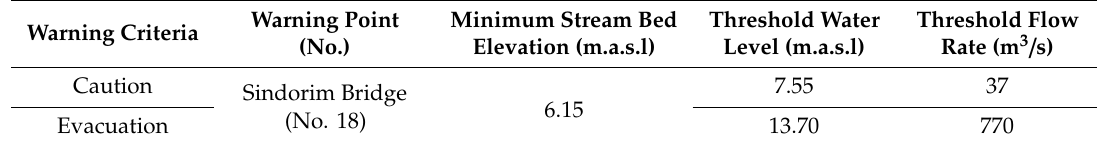
Table 3. Criteria for issuing a flood warning or an evacuation order for Dorim Stream.